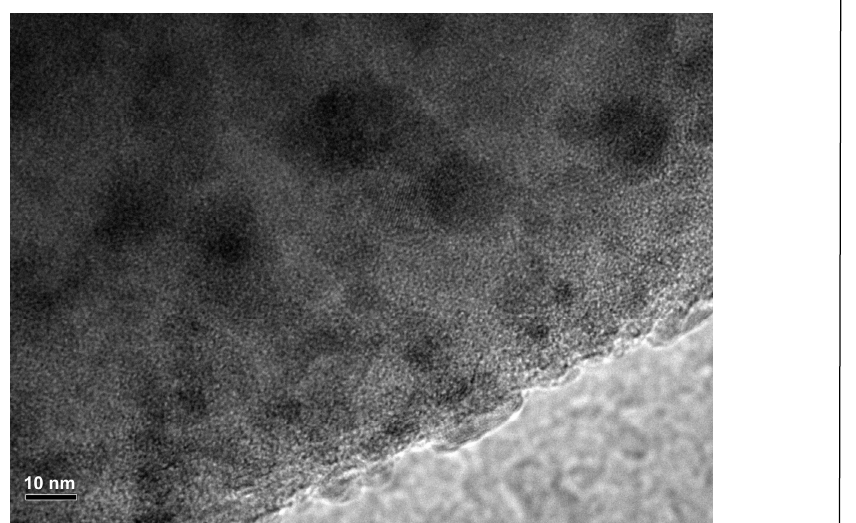
Figure 2 – Transmission electron micrograph of nanocomposite α -Fe2O3/SiO2